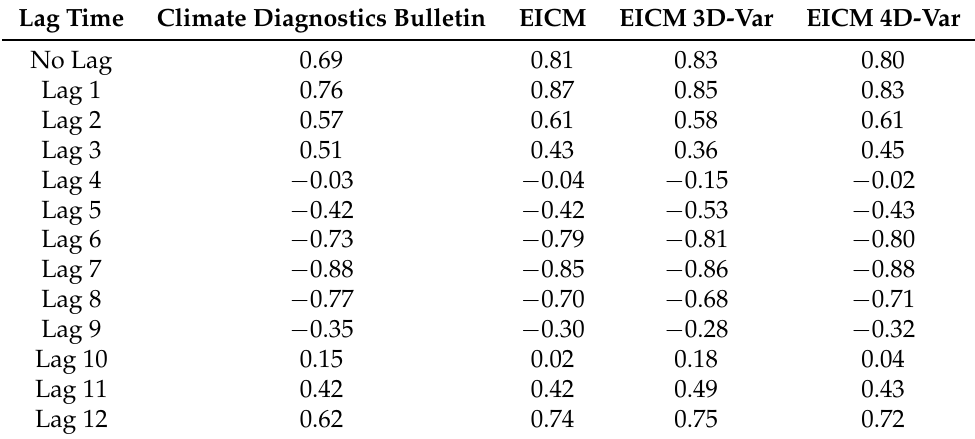
Table 3. The correlation coefficient between the SSTA and the precipitation in